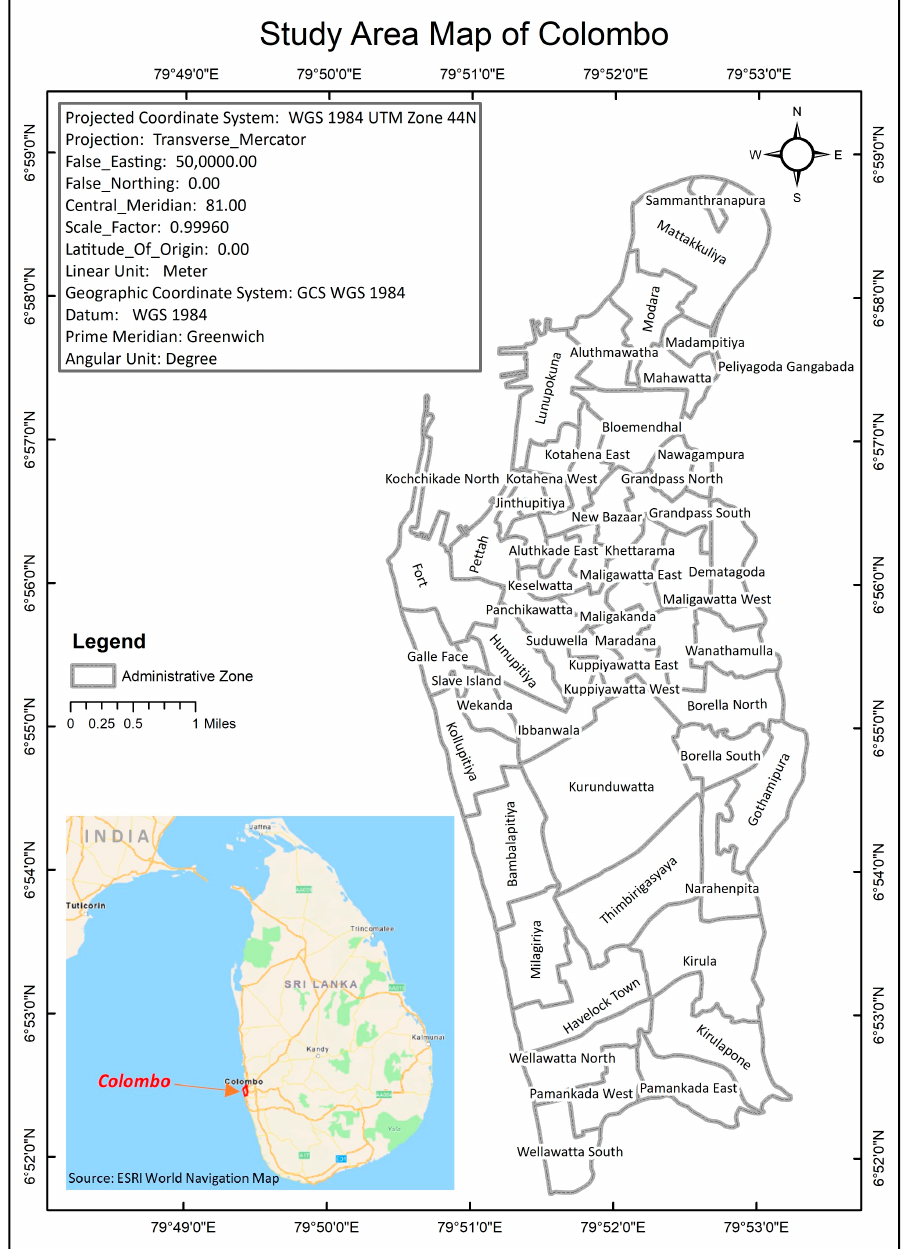
Figure 1. Sri Lanka context, with details of the study area (Colombo Municipal Council).